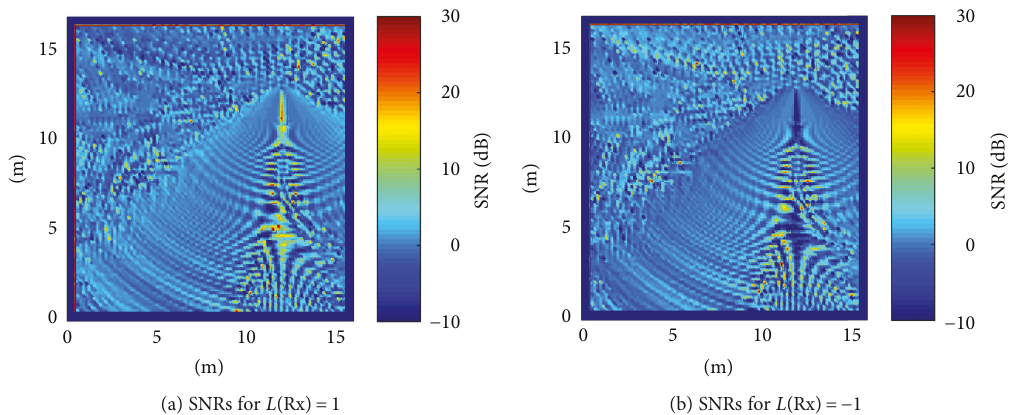
Figure 7: SNRs calculated for the lecture room with the transmitter of L (Tx) =1 using the antennas in Figure